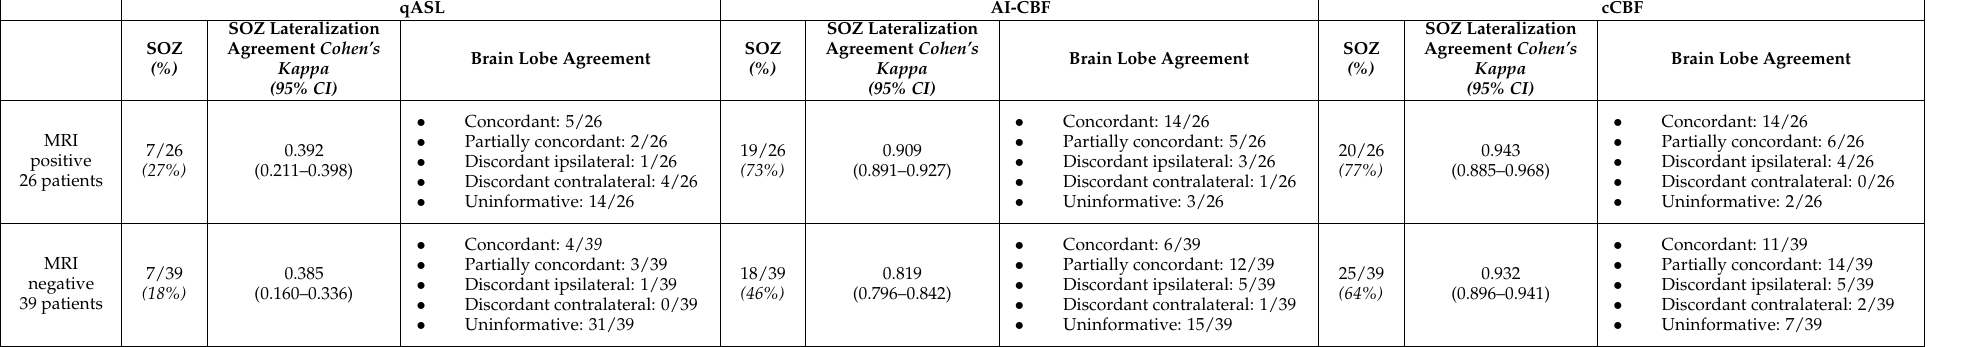
Table 1. Comparisons of three ASL analyses with the electro-clinical definition of the presumed Seizure Onset Zone